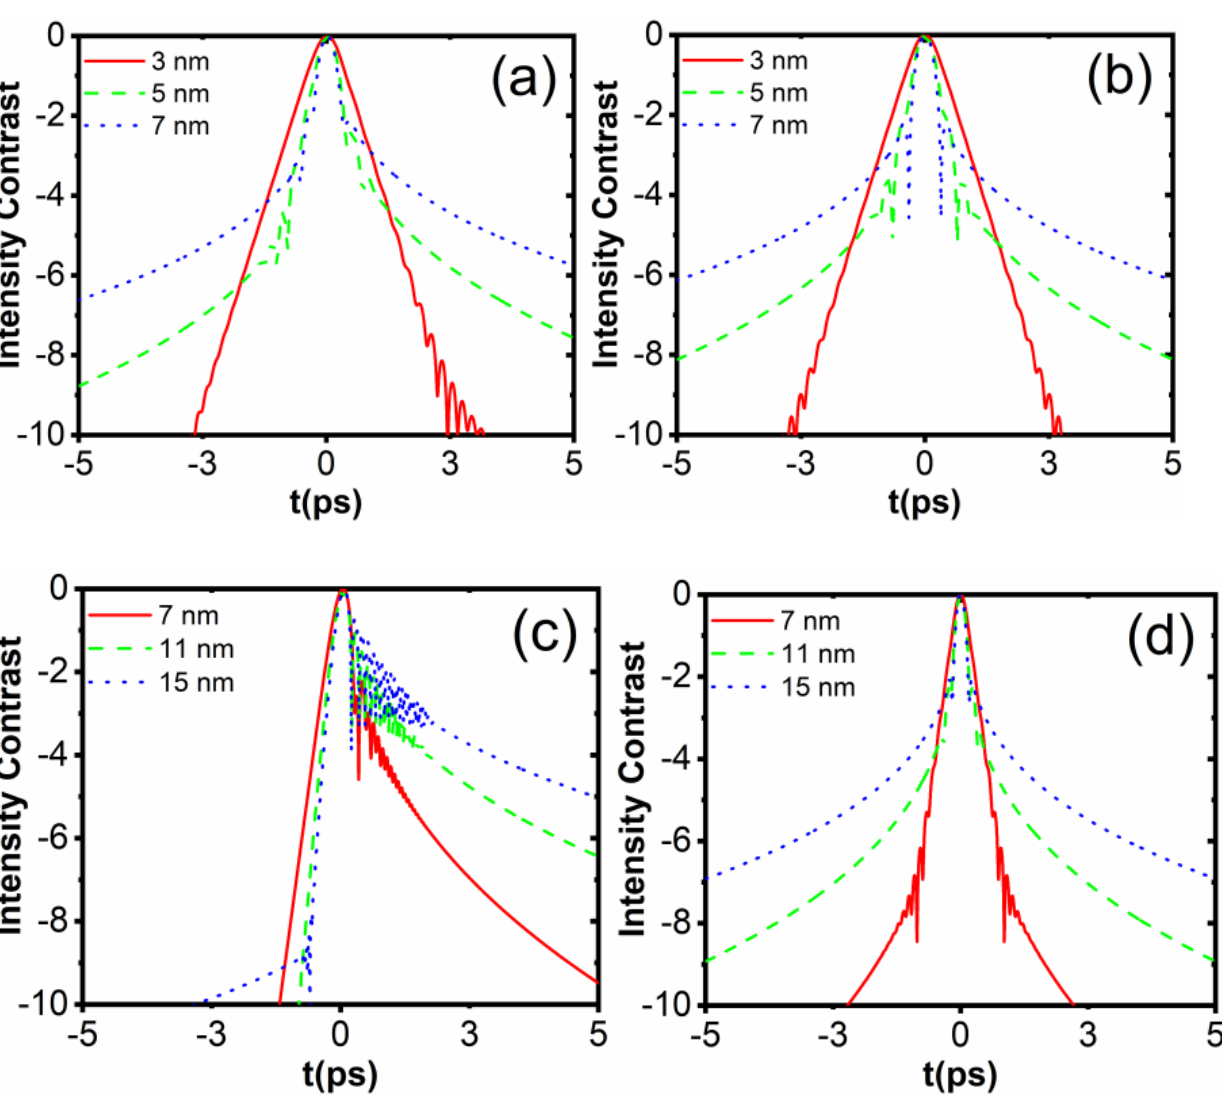
Figure 5. ( a ) Intensity contrast for bandwidths of 3 nm, 5 nm, and 7 nm, which includes the TOD of 1.3 × 10 6 fs 3 and FOD of − 3.9 × 10 8 fs 4 ; ( b ) the contrast only with the FOD, with other parameters the same as in ( a ); ( c ) the contrast for bandwidths of 7 nm, 11 nm, and 15 nm including the TOD of 6 1.3 10 fs 3 and FOD of 7 3.8 10 − fs 4 ; ( d ) the contrast only considering the FOD, with other pa- rameters the same as in ( c ).